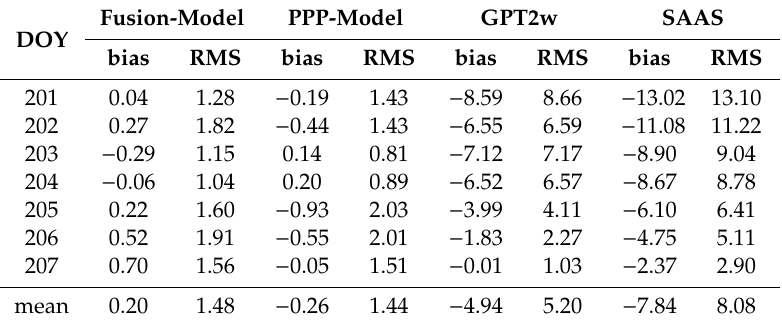
Table 3. Daily mean precision (cm) of troposphere models in July. Fusion-Model PPP-Model GPT2w SAAS DOY bias RMS bias RMS bias RMS bias